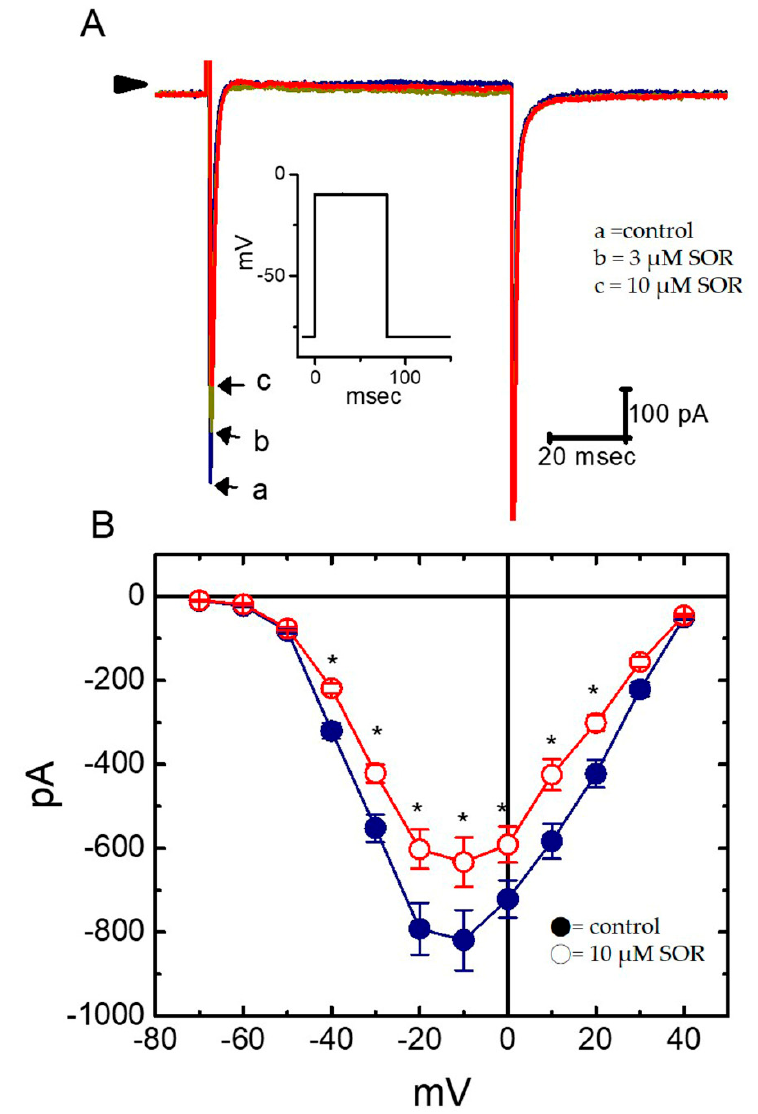
Figure 5. Inhibitory effect of SOR on the voltage-gated Na + current ( I Na ) in NRVMs. ( A ) Superimposed I Na traces when a cell was depolarized from − 80 to − 10 mV (indicated in the inset). Label ‘a’ is the control and label ‘b’ and ‘c’ were obtained 2 min after the application of 3 and 10 μ M SOR, respectively. Arrowhead indicates the zero current level, and the calibration mark applies to all current traces. ( B ) Averaged I – V relationships of the peak I Na obtained in the absence ( ● ) and presence ( ○ ) of 10 μ M SOR ( n = 8–10 for each point). The current amplitudes were measured at the beginning of each depolarizing pulse. * Significantly different from controls ( p < 0.05).